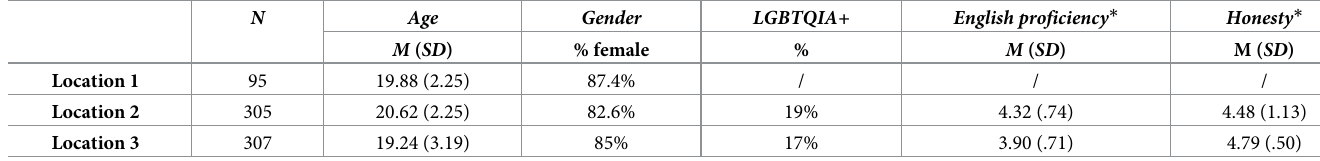
Table 1. Sample descriptives in all three study